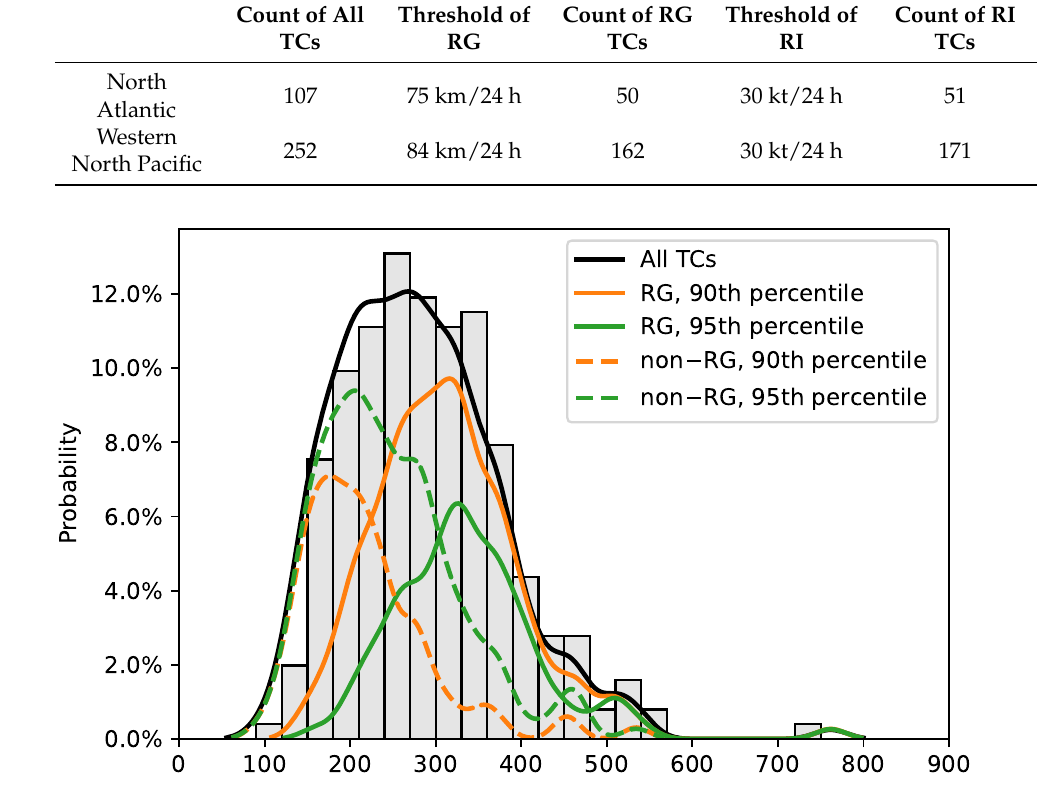
Figure 4. Probability distribution function (PDF) of the lifetime maximum size (LMS) for the western north Pacific TCs. The original and smoothed distribution of all TCs are denoted by the grey histograms and black lines, respectively. The smoothed PDFs for the TCs that undergo rapid growth, defined as the 90th percentile ( ≥ 84 km/24 h) and 95th (108 km/24 h) percentile, are denoted by the orange and green lines, respectively. The PDFs are smoothed using kernel density estimation with a bandwidth of